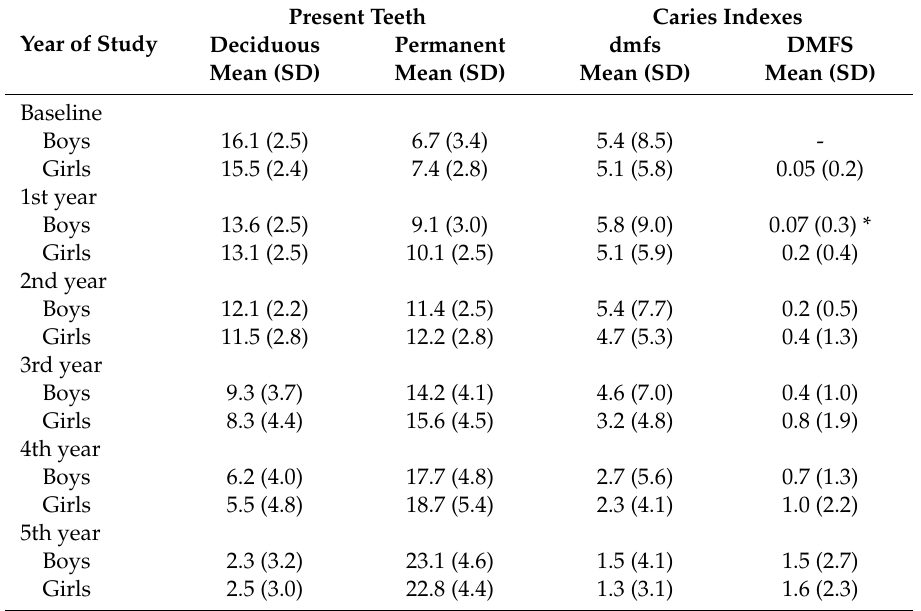
Table 1. Distribution of clinical markers in the follow-up, based on sex.